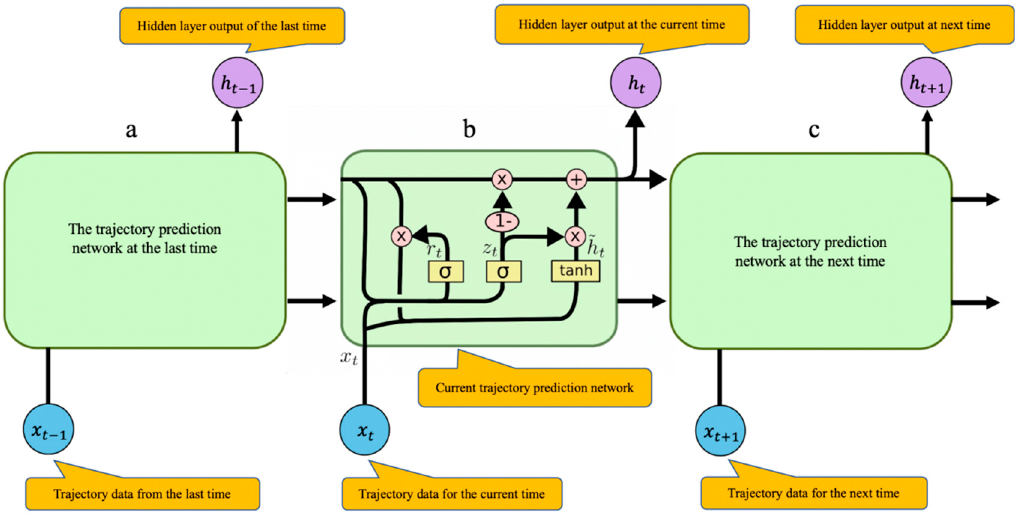
Figure 12. Schematic diagram of the trajectory prediction model based on the GRU neural network: ( a ) GRU unit at the last time; ( b ) GRU unit of the current time, which describes the detailed information of the transfer process; and ( c ) GRU unit at the next time.